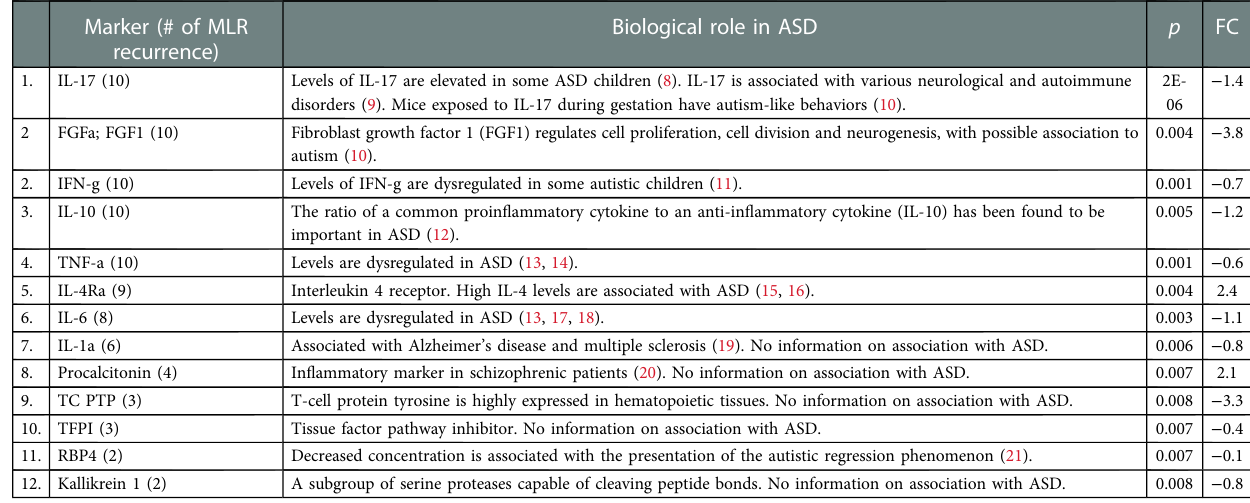
TABLE 2 Identi fi ed diagnostic biomarkers and their potential biological role in autism spectrum disorder. Marker (# of MLR recurrence)